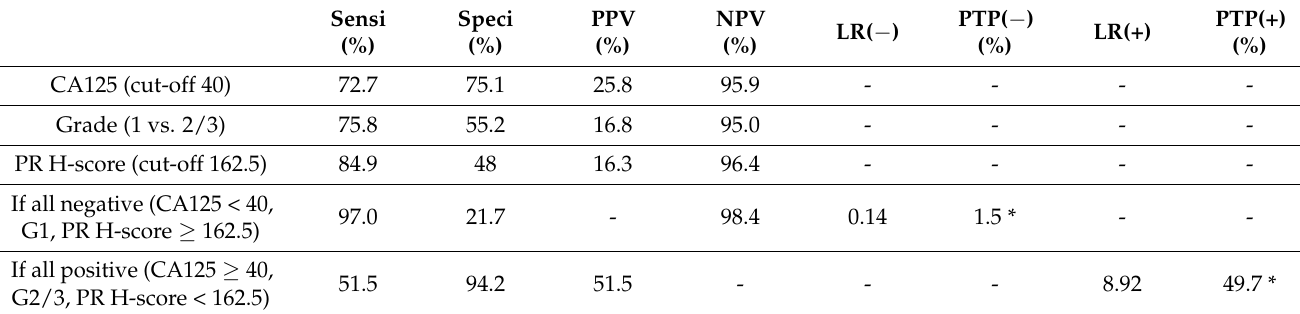
Figure 4. ( A ) A nomogram predicting the probability of lymph node metastasis in patient with endometrioid endometrial cancer. The probability is calculated by drawing a line to the point on the axis for each of the following variables: preoperative CA125, tumor grade, and PR H-score. The points for each variable are summed and located on the total point line. Next, a vertical line is projected from the total point line to the predicted probability bottom scale to obtain the individual probability of lymph node metastasis; ( B ) The calibration plot for the prediction model. Table 3. Predictive performance of different variables and different